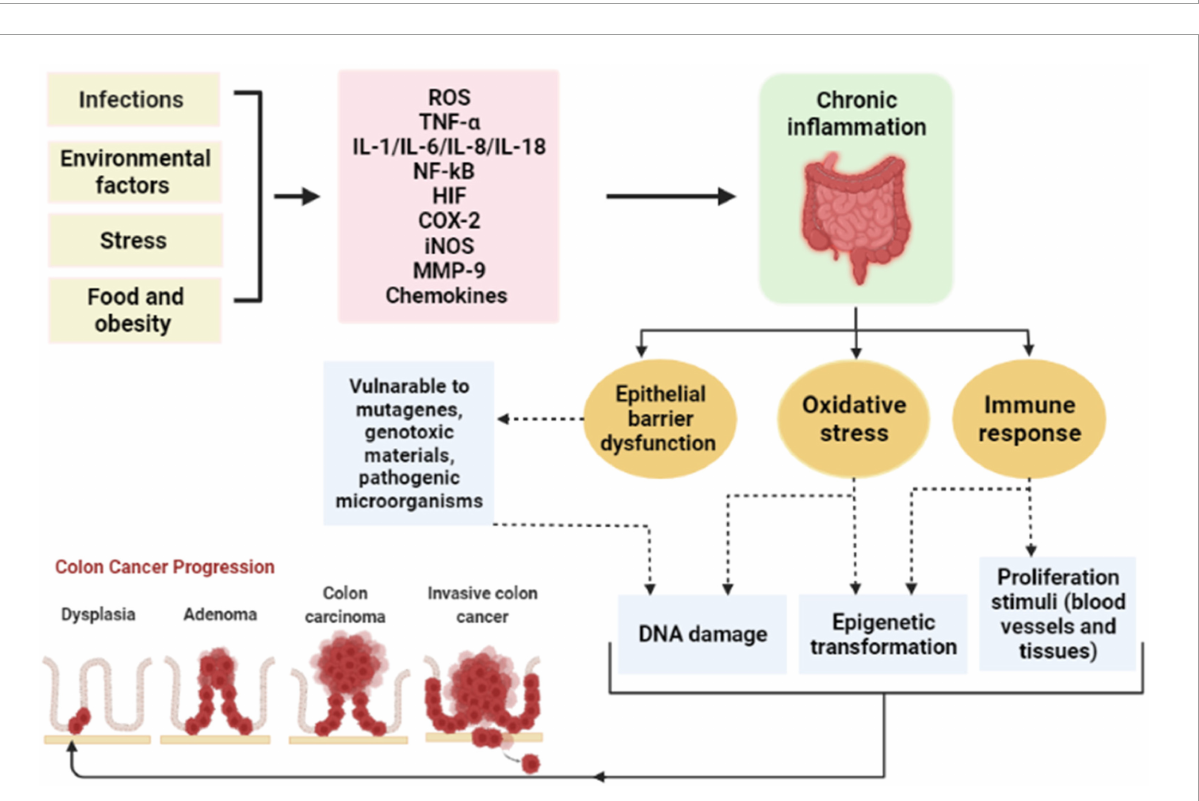
FIGURE3 The correlation between chronic inflammation and the development of CRC. ROS, reactive oxygen species; TNF- α , tumor necrosis factor-alpha; IL, interleukin; NF-kB, nuclear factor kappa B; HIF, hypoxia-inducible factor; COX-2, cyclo-oxygenase-2; iNOS, inducible nitric oxide synthase; MMP-9, matrix